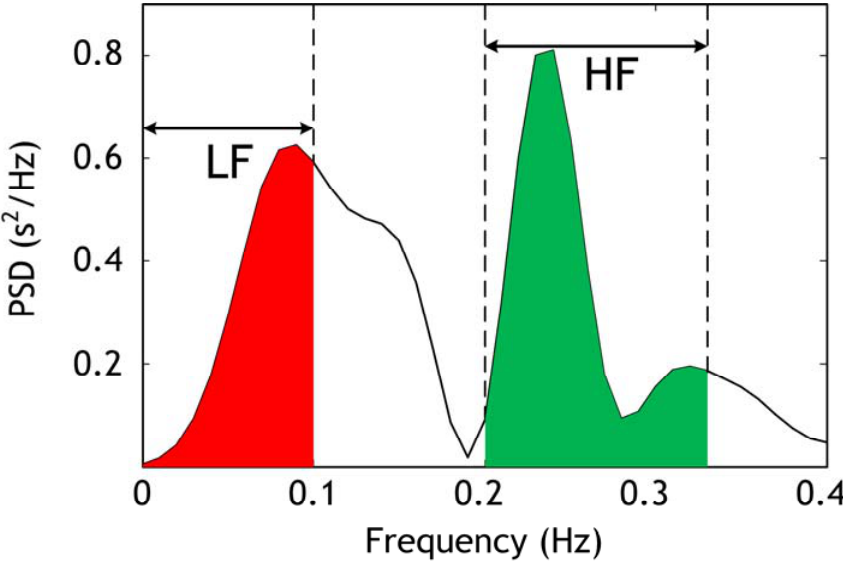
Figure 9. Power spectrum density (PSD) of 30-s length respiration signal corresponding to the record 1 of the sleep dataset. Low frequency (LF) is shown in red while high frequency (HF) is shown in